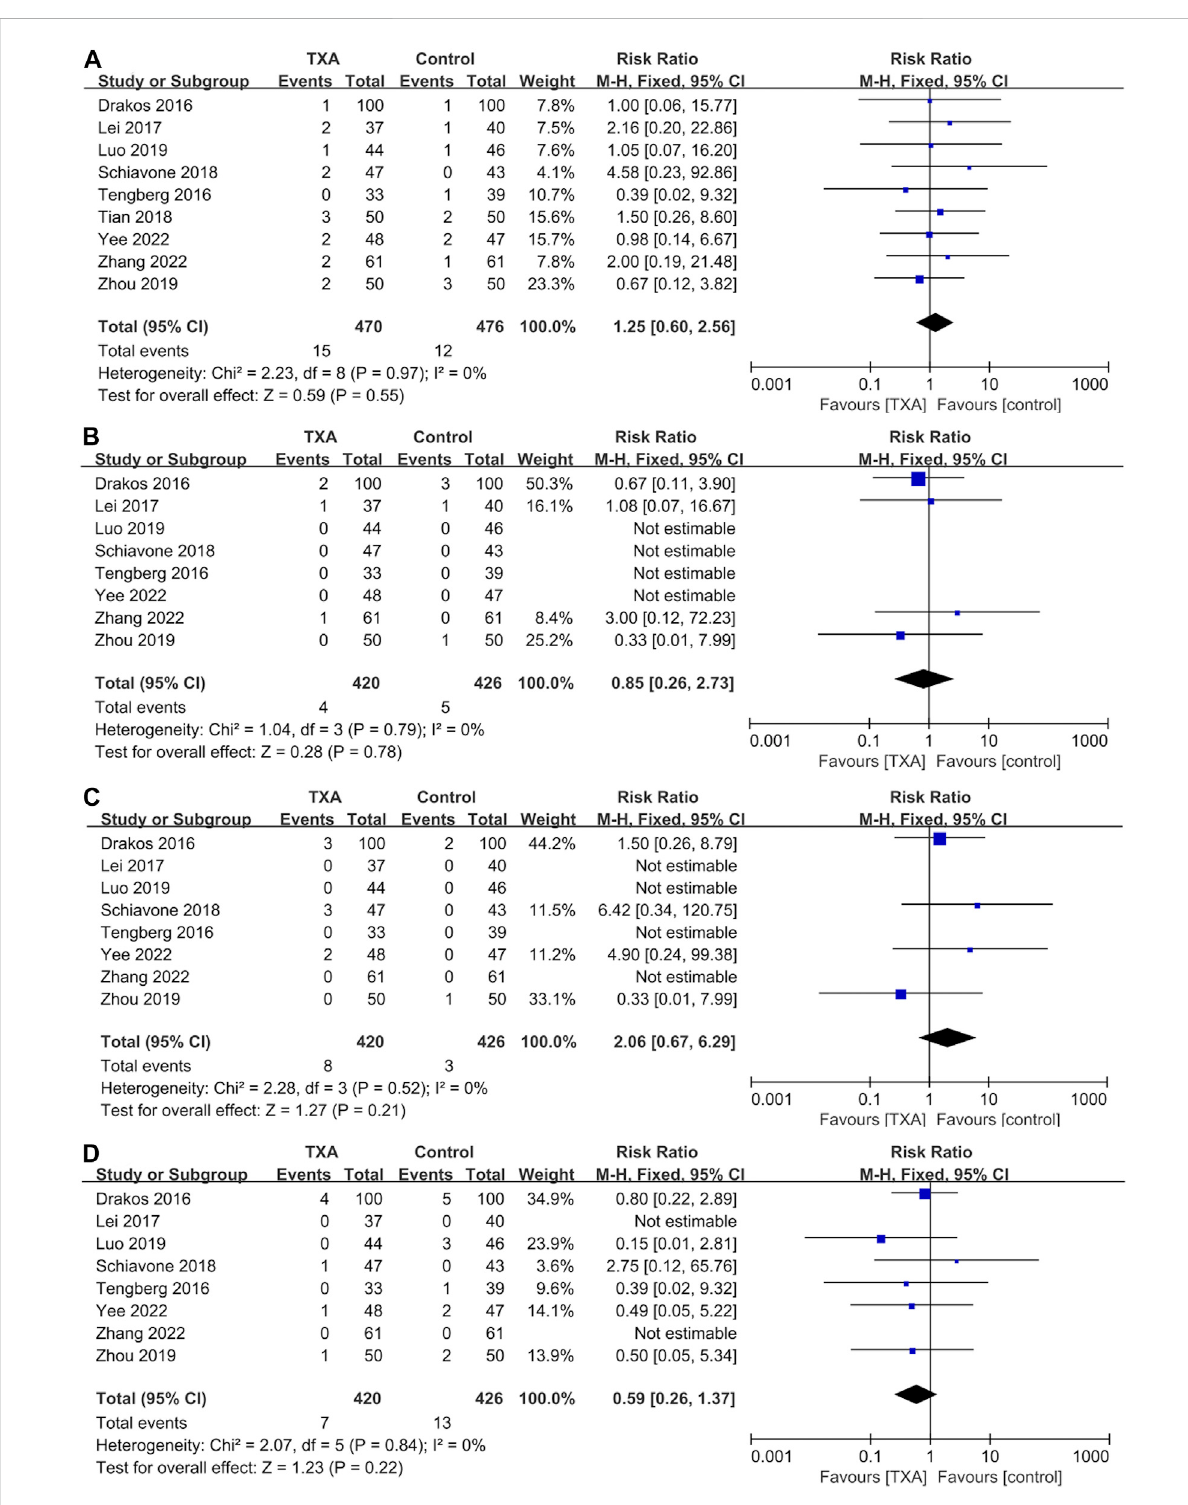
FIGURE 6 Forest plot showing the incidence of thromboembolic events of TXA group vs. control group. (A) Deep vein thrombosis. (B) Pulmonary embolism. (C) Myocardial infarction. (D) Ischemic